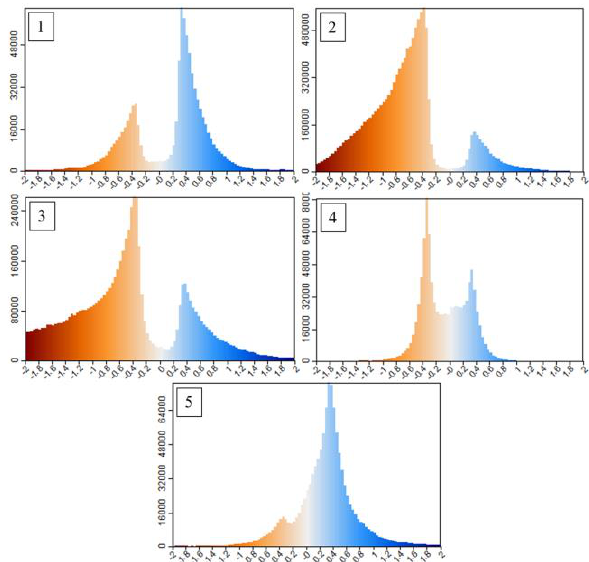
Figure 9 . Change histograms per process (X-axis: Distance [m]; Y-axis: Frequency), 1. Fluvial Processes , 2. Rock Glacier Movement & Landslides , 3. Channel Erosion & Debris Flow , 4. Rockfall Release & Deposition , 5. Vegetation & Anthropogenic Change